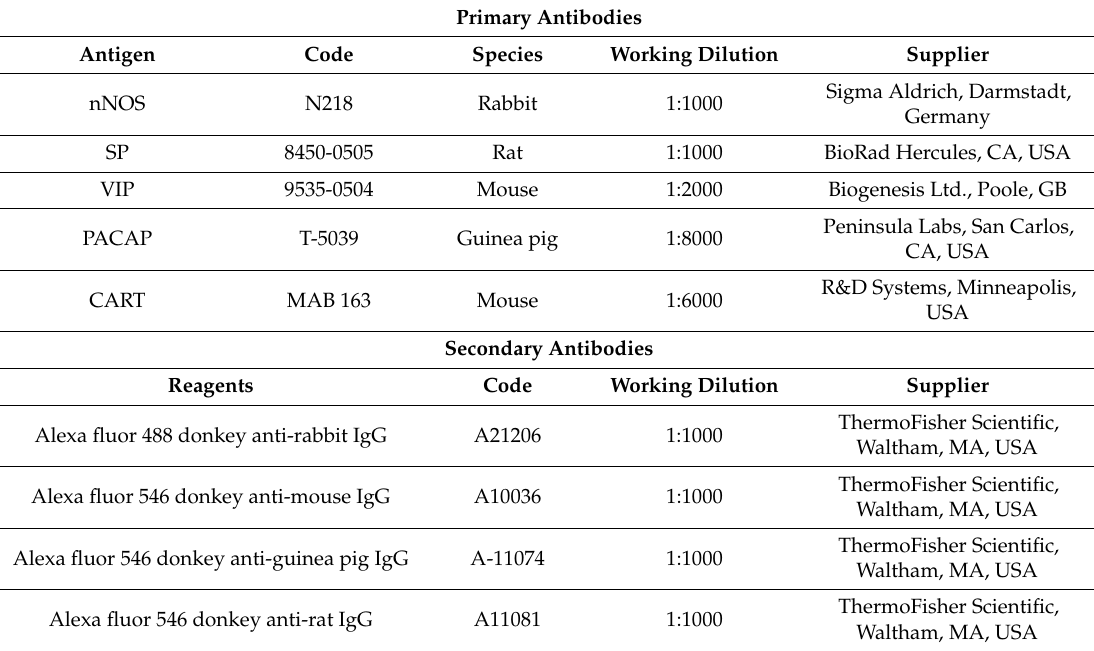
Table 3. List of antisera and reagents used in immunohistochemical